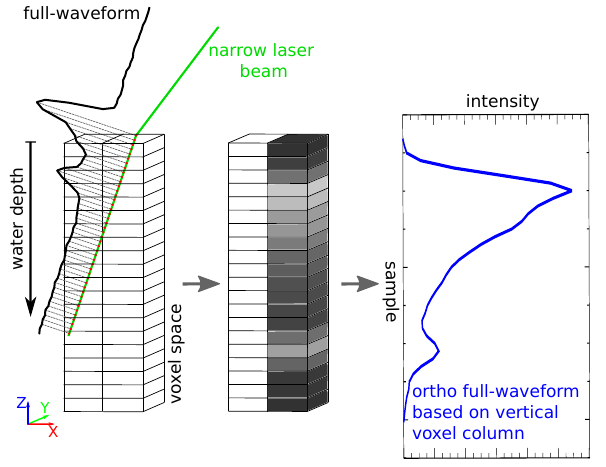
Figure 1. Principle of ortho full-waveforms generation.